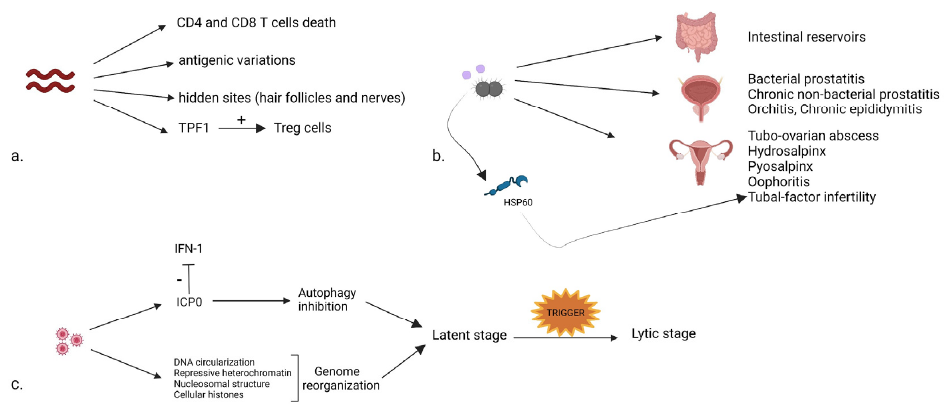
Figure 3. Chronicization mechanisms. Syphilis ( a ), Neisseria gonorrhoeae and Chlamydia ( b ), and Herpes Simplex ( c ) display complex immune escape mechanisms within hair follicles, nerves, pelvic organs, and intestines. TPF1 = treponemal protein belonging to the bacteriominiferritin family; HSP60 = heat shock protein 60; ICP0 = infected cell protein